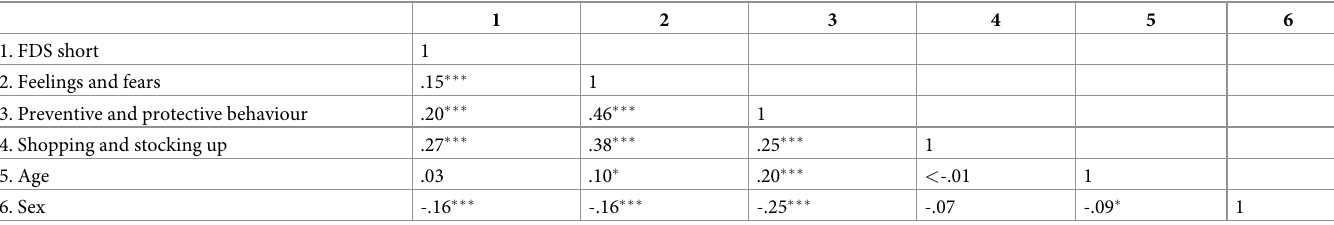
Table 2. Pearson’s correlations for food disgust sensitivity, attitudes or behaviours related to the COVID-19 pandemic, age, and sex N = 519.